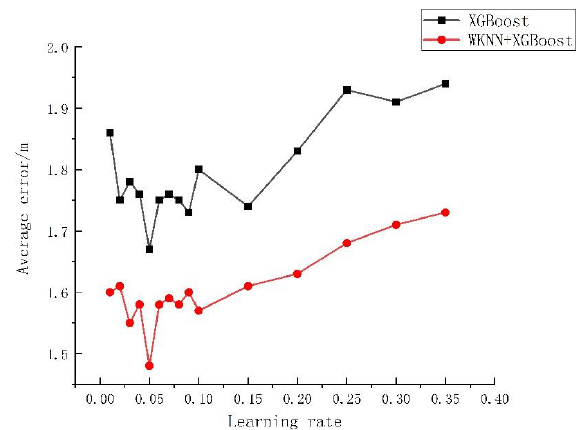
Figure 7. The influence of learning rate on error.